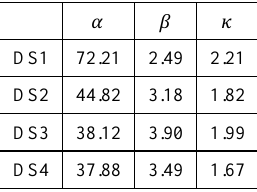
Table 1. The ML estimates of model parameters for four data sets